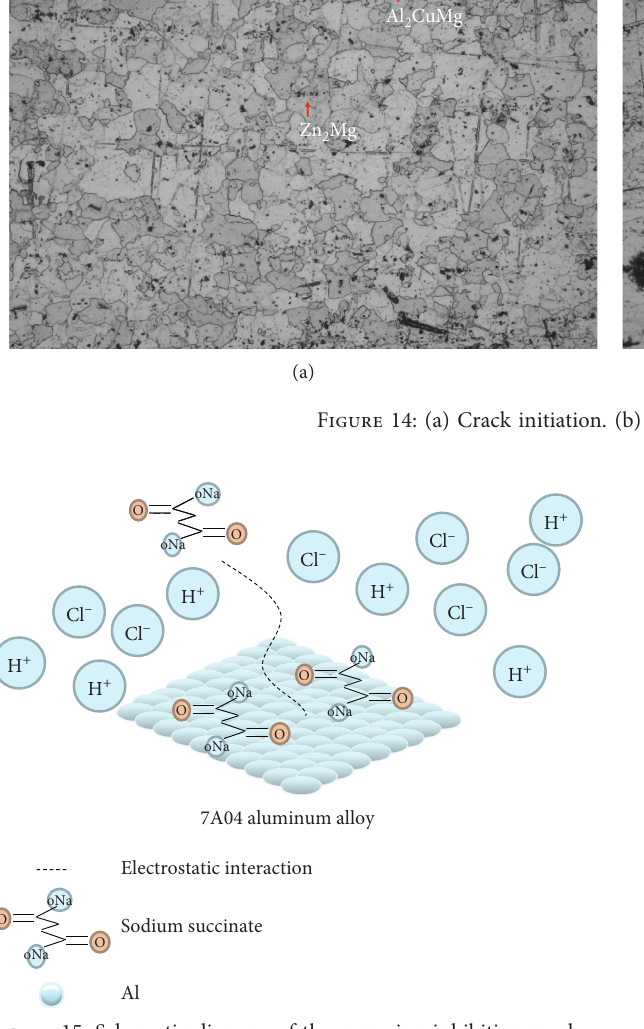
Figure 15: Schematic diagram of the corrosion inhibition mech- anism of sodium succinate.